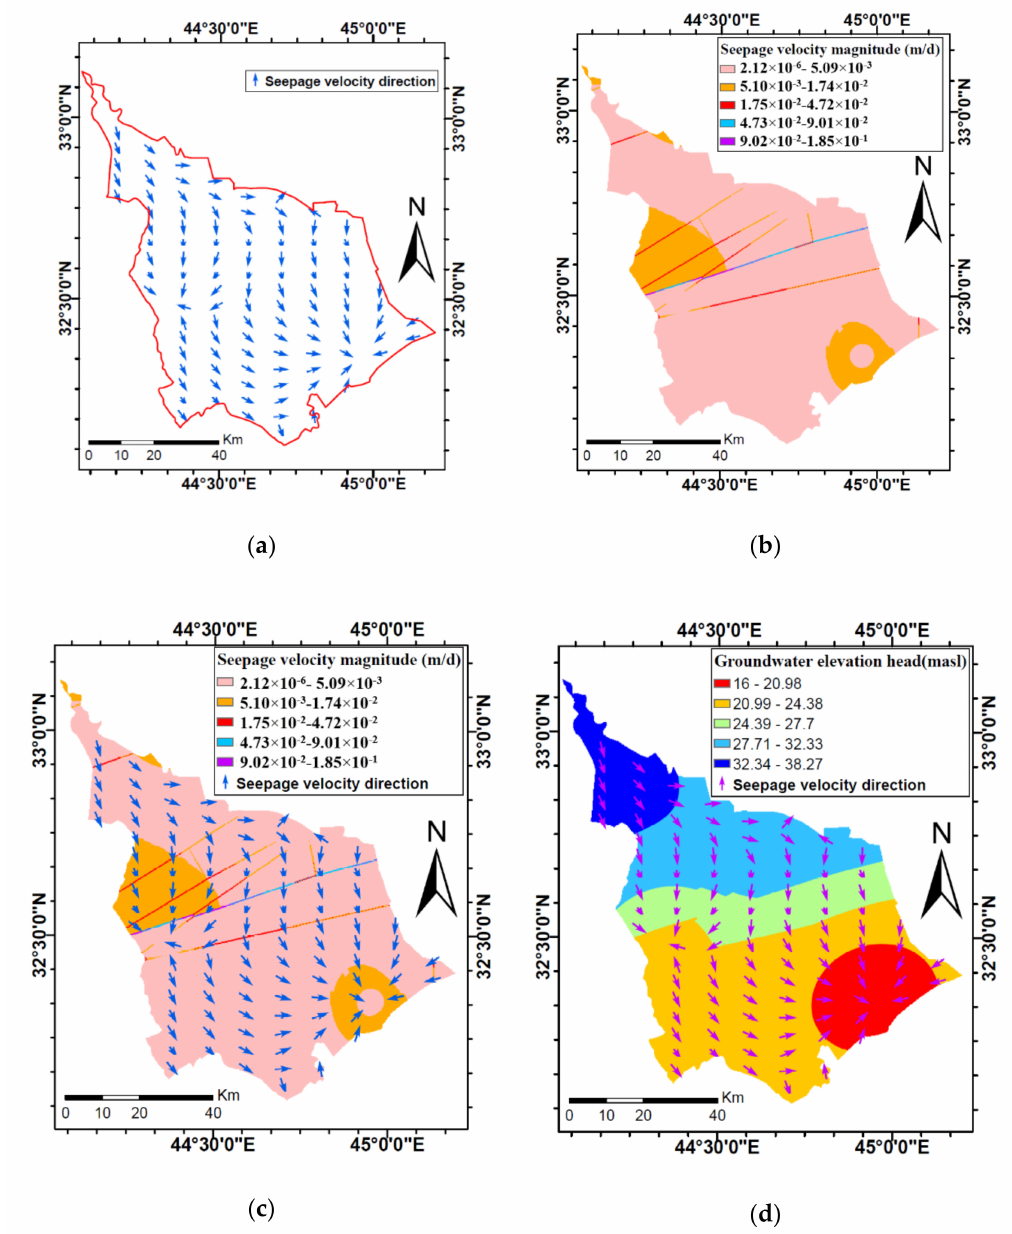
Figure 12. Seepage velocity maps for Babylon groundwater: ( a ) direction map; ( b ) magnitude map; ( c ) merged magnitude–direction map, ( d ) seepage direction–groundwater elevation head